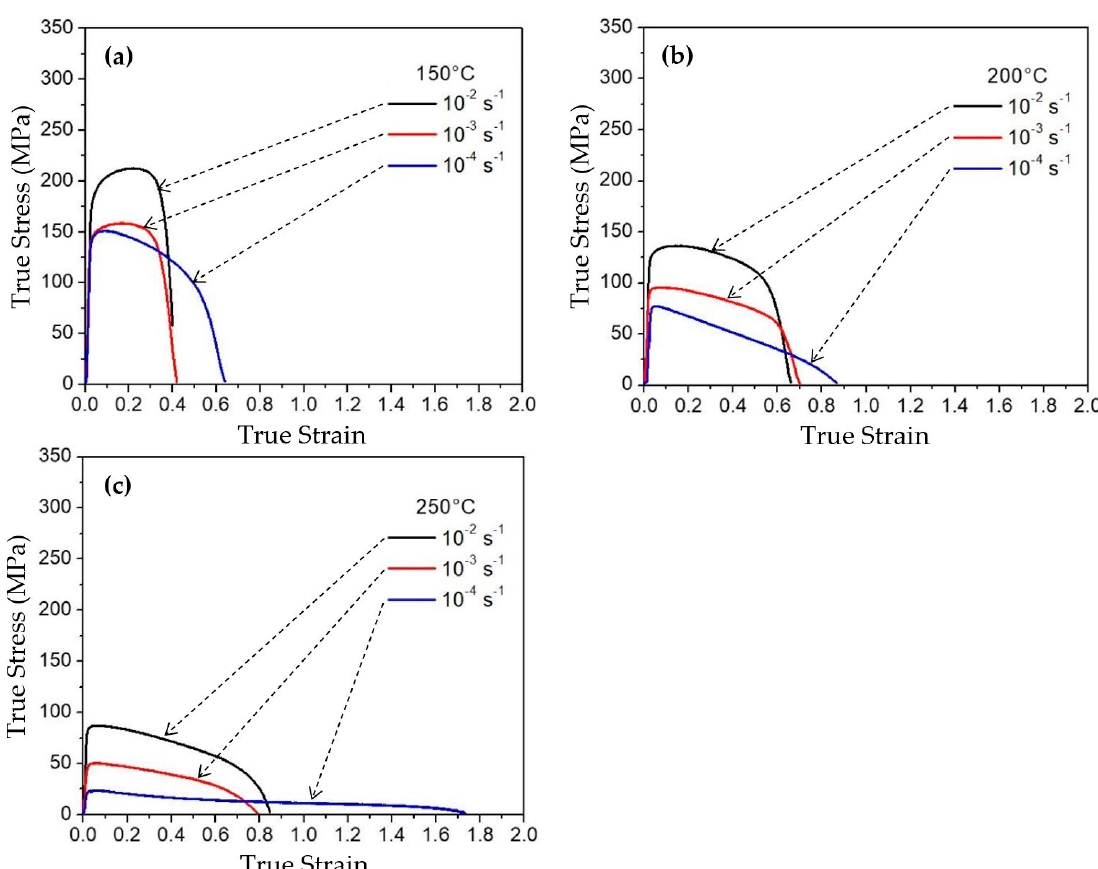
Figure 5. True stress–true strain curves at different temperatures and strain rates: ( a ) 150, ( b ) 200, and ( c ) 250 °C.